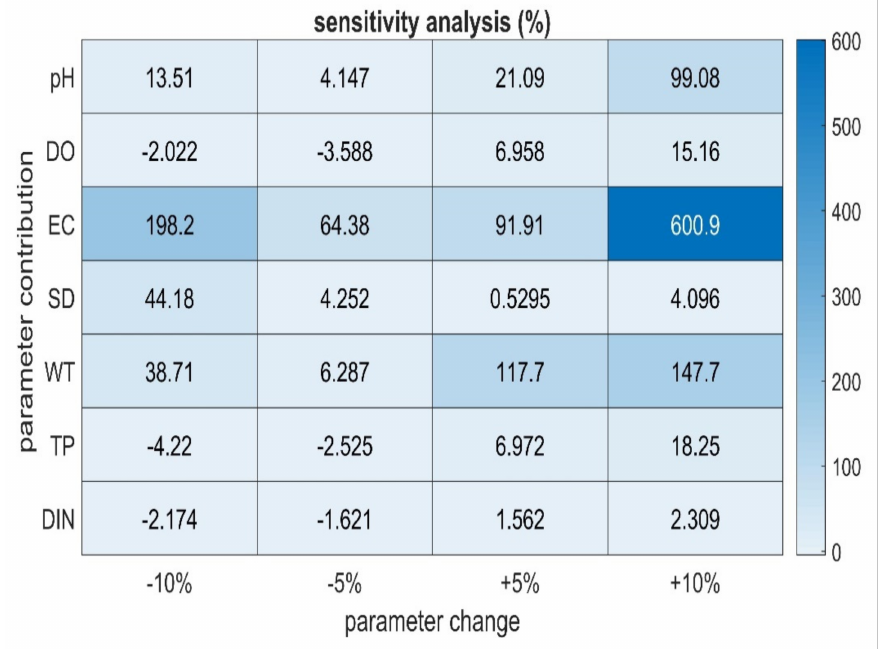
Figure 7. The sensitivity analysis calculating parameter contribution (%) after a change. Where ANN’s input parameters: pH; dissolved oxygen (DO); electric conductivity (EC); Secchi disk (SD) depth; water temperature (WT); total phosphorus (TP); and dissolved inorganic nitrogen